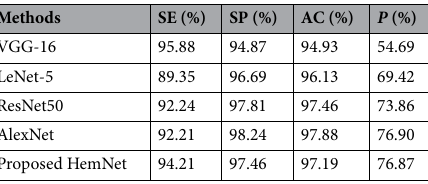
Table 2. Classification of HEs using various models on the DIARETDB1 Dataset.